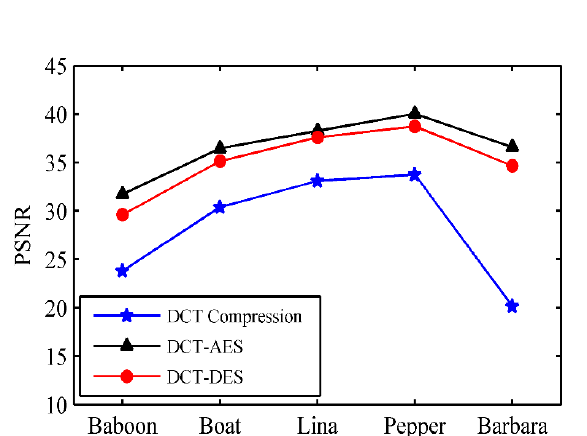
Figure 8 . Graphical representation of comparison of PSNR values